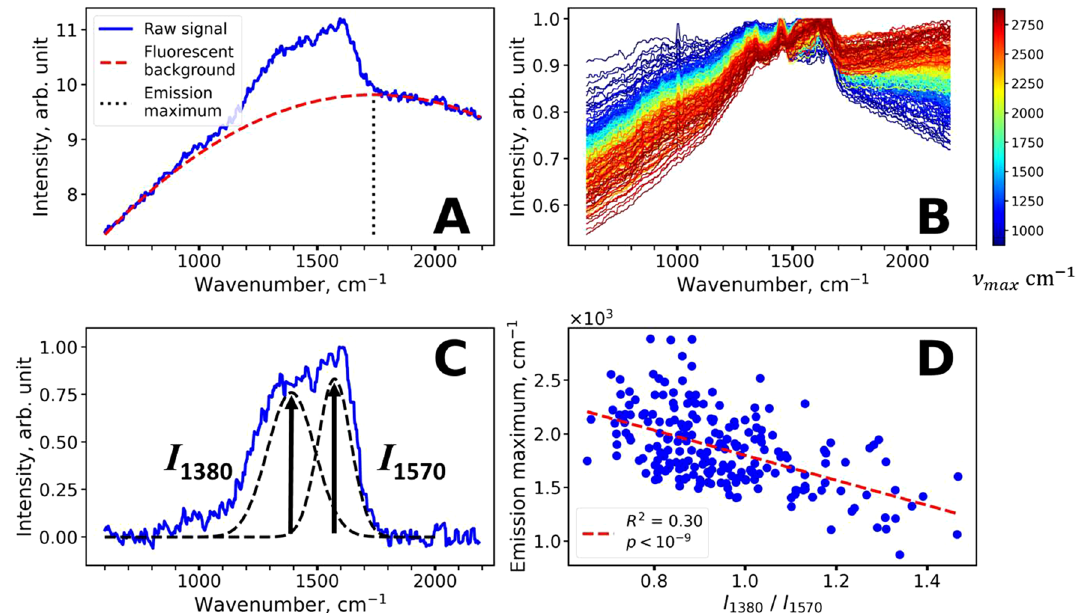
Figure 5. Assessment of spectral features of the NIR-excited fluorescence and its correlation with melanin- related Raman bands. ( A ) Illustration of the emission maximum estimation procedure. Fluorescence background was approximated by a 2 nd order polynomial, so the emission maximum could be calculated as a center of the parabola. ( B ) Representative spectra with high fluorescence (Fl-FP > 10) color-coded according to the position of the center of the parabola. ( C ) Typical Raman spectrum of the skin with high melanin content obtained for a volunteer with skin type III after sunlight exposure at a depth of 38 µm ( stratum basale ). Melanin twin peaks are denoted as dashed lines. ( D ) Correlation between the fluorescence emission maximum and the ratio of melanin Raman bands at 1,380 and 1,570 cm −1